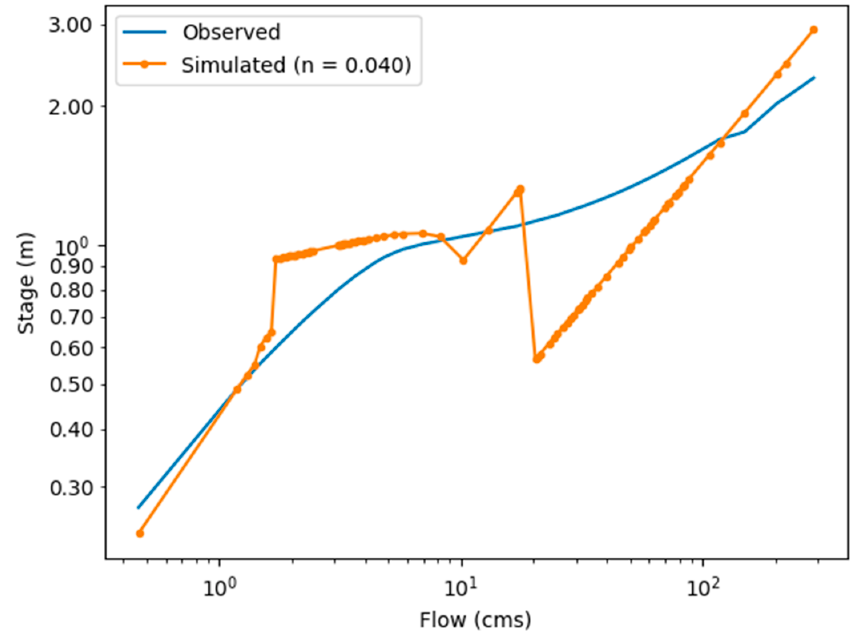
Figure 8. Example of a poor rating curve comparison from Raspy-Cal for the Los Angeles River, Los Angeles County, CA, USA. Plot shows a cross section with a low flow channel (F300).